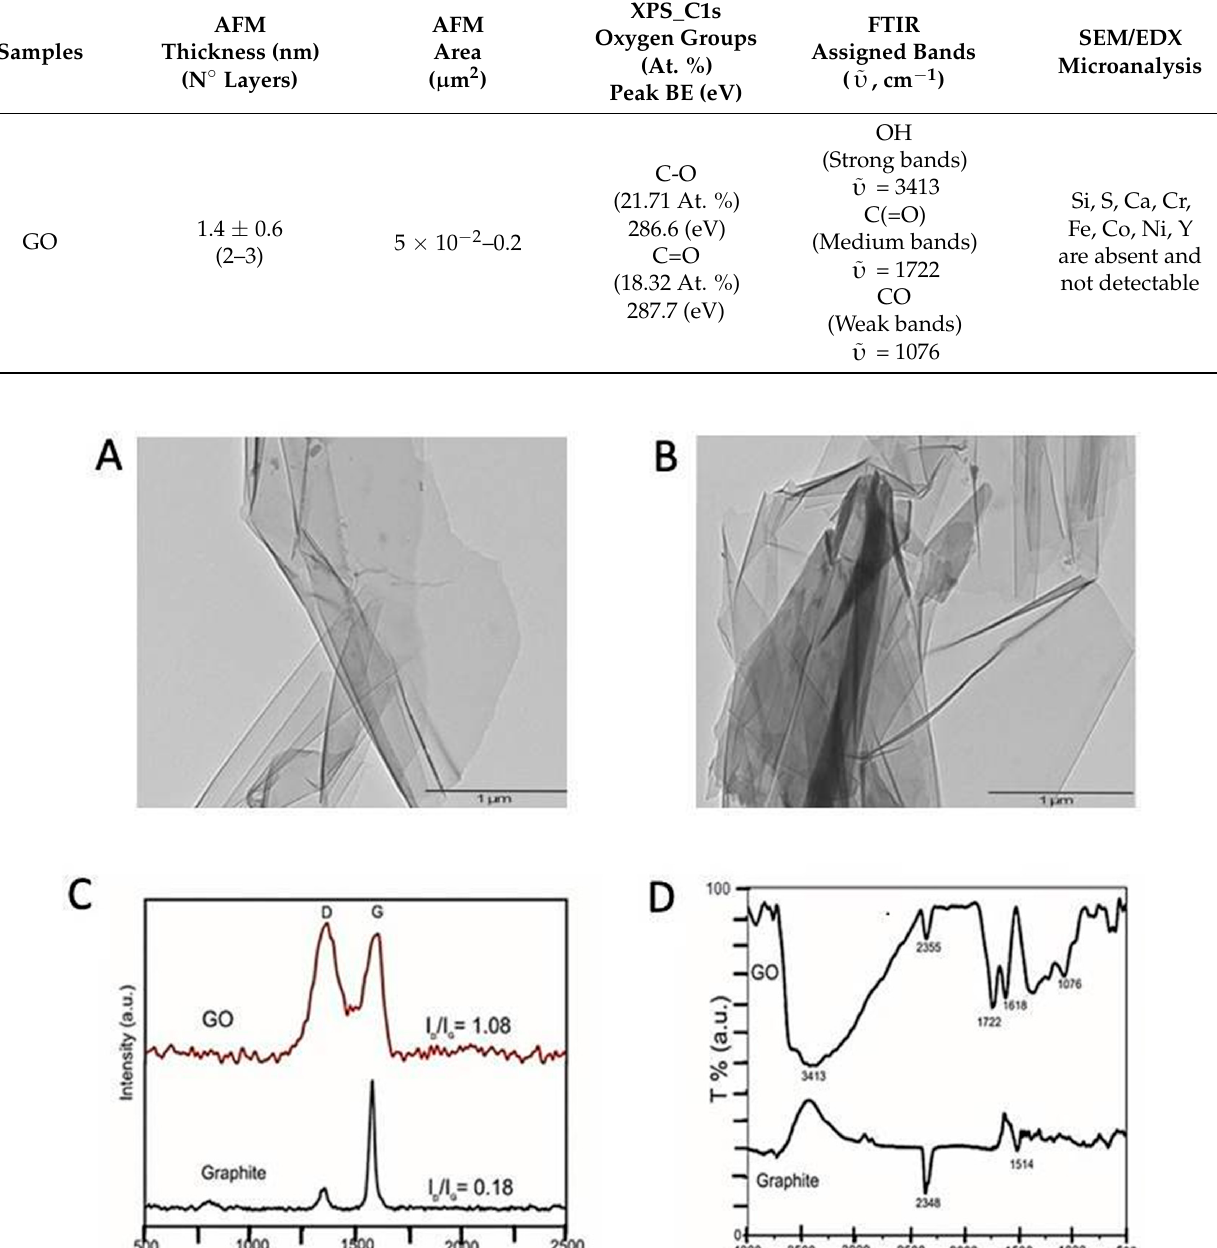
Table 1. Characterization of functionalized graphene oxide, GO.